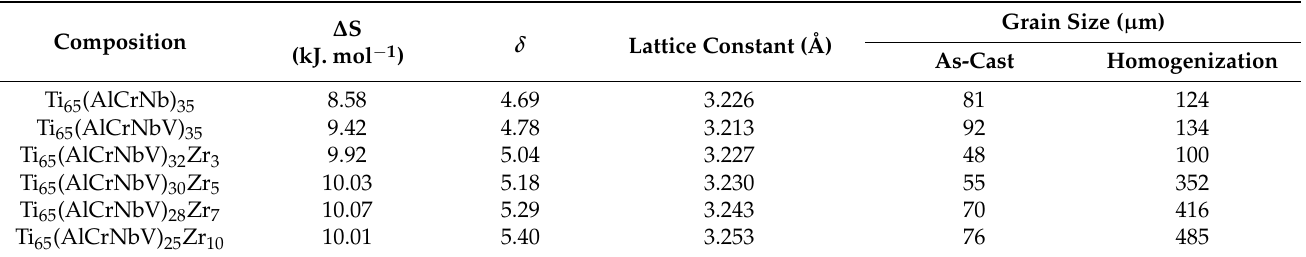
Table 1. Parameters of as-cast Ti 65 (AlCrNb) 35 , Ti 65 (AlCrNbV) 35 , and Ti 65 (AlCrNbV) 35-x Zr x (x = 3, 5, 7, 10) MEAs